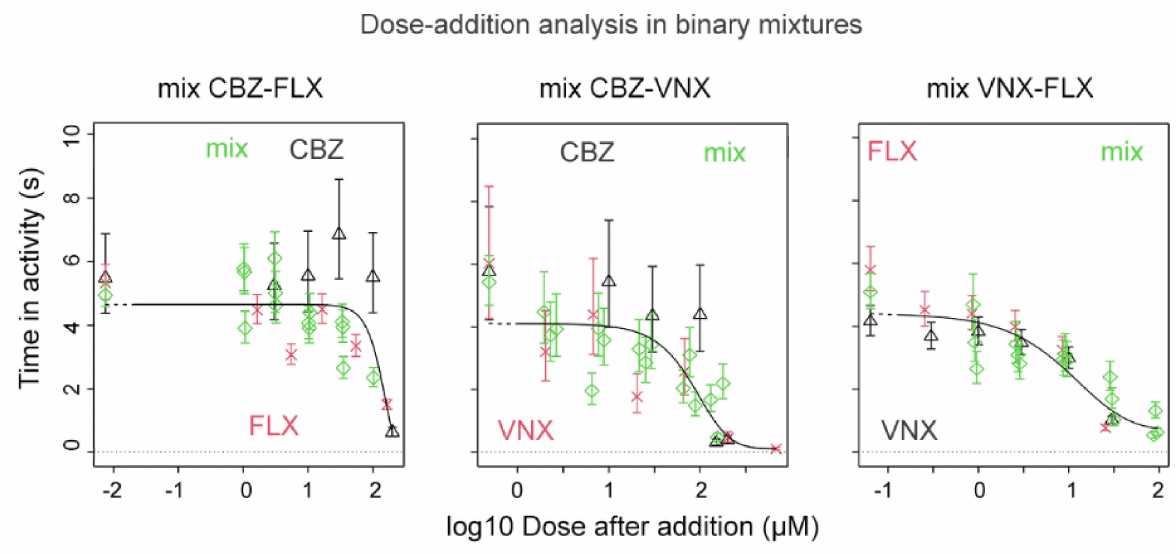
Figure 5. Dose–response mixture effects on swimming activity in zebrafish embryos upon exposure to a mixture of CBZ and FLX, CBZ and VNX, and VNX and FLX. The reference compound (black triangles/lines) is combined with the second compound (red crosses/lines); green diamonds/lines represent the corresponding mixtures. Doses of the second compound and of the mixtures are scaled to the reference compound. The mixtures do not deviate systematically from the overall fit, indicating that the combined effect results from dose